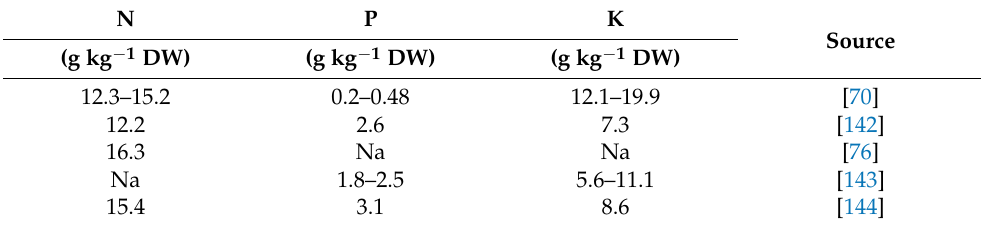
Table 2. N, P, and K concentration in green